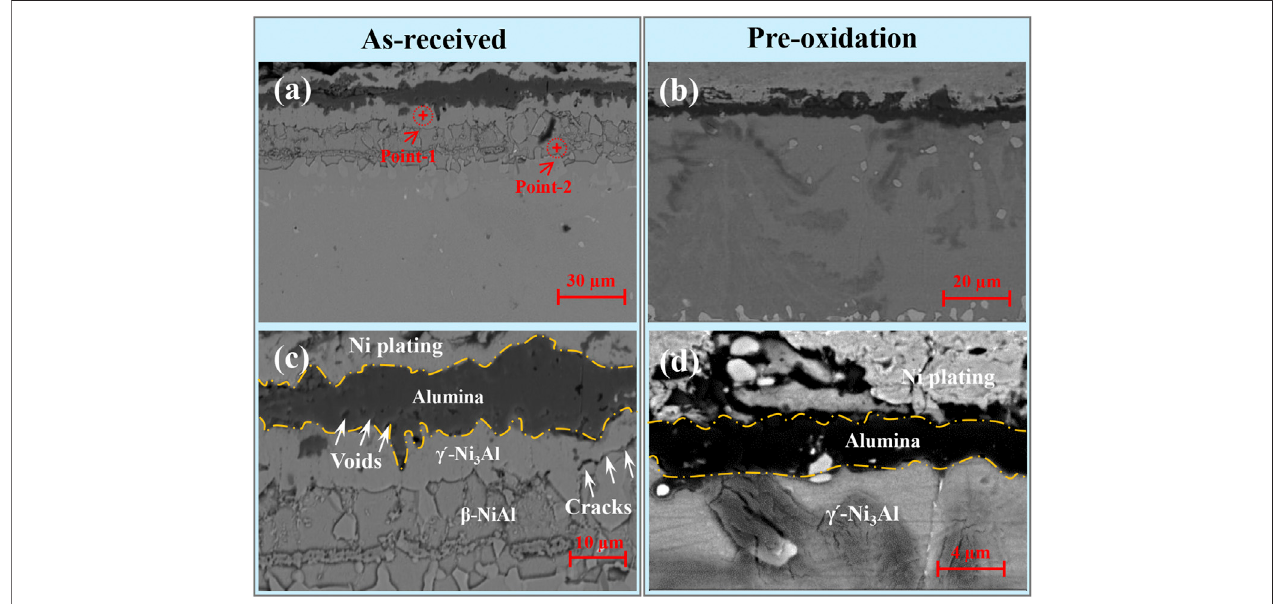
FIGURE 4 | Cross-sectional microstructures of the aluminide coating after hot corrosion for 120 h in Na 2 SO 4 salt at 1050 ° C for (A,C) as-received and (B,D) pre- oxidation.